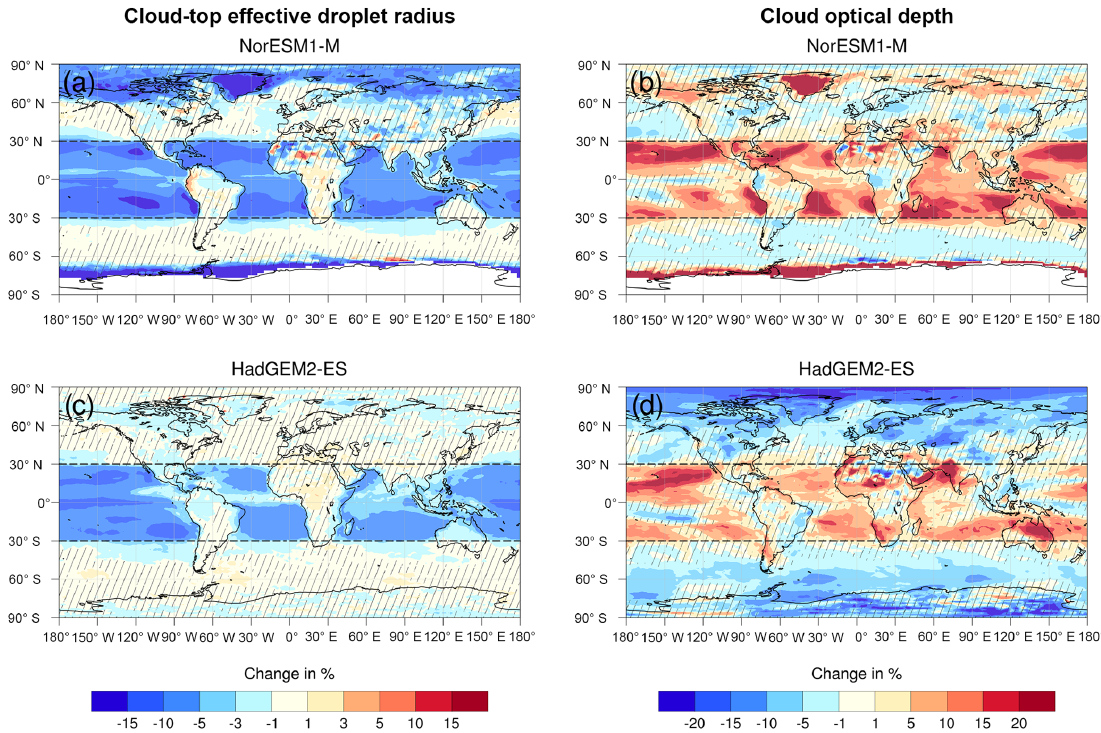
Figure 8. Mean relative change between G4sea-salt and RCP4.5 in cloud-top effective radius for NorESM1-M (a) and HadGEM2-ES (c) and in cloud optical depth for NorESM1-M (b) and HadGEM2-ES (d) . The maps represent average change due to sea spray climate engineering over the period 2035–2065. Hatching denotes areas where changes are not significant at the 95% confidence level (Student t test with respect to variance of annual mean